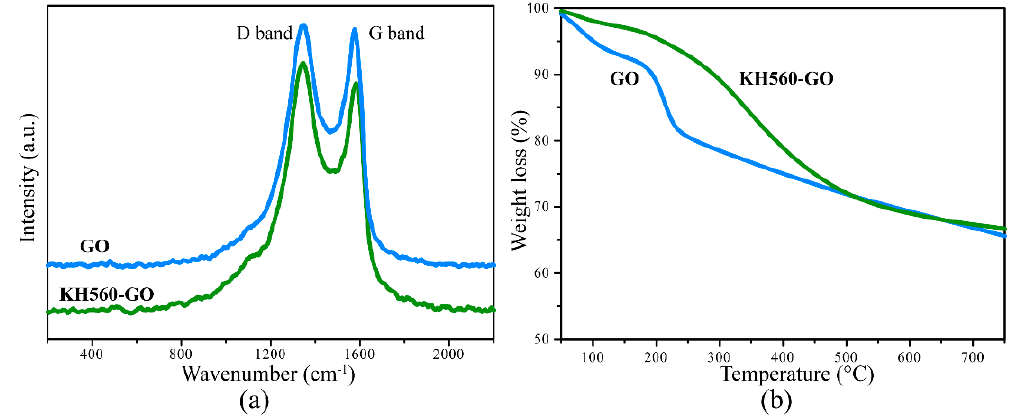
Figure 1. ( a ) Raman spectra and ( b ) TGA profiles of GO powder and GO-KH560 powder.